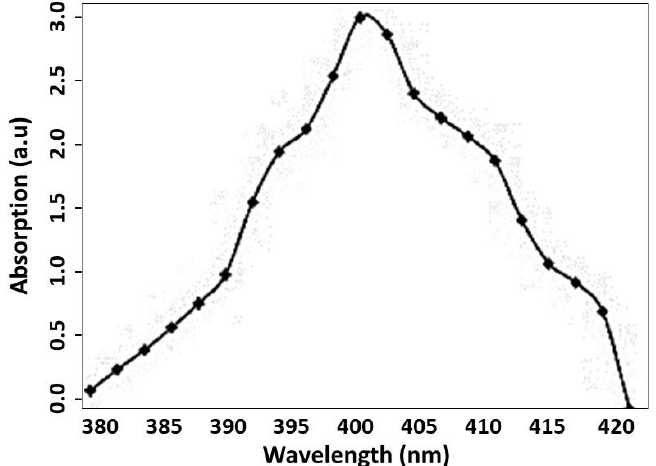
Figure 6. UV spectrum of the AgNPs dispersed in ethanol solution.